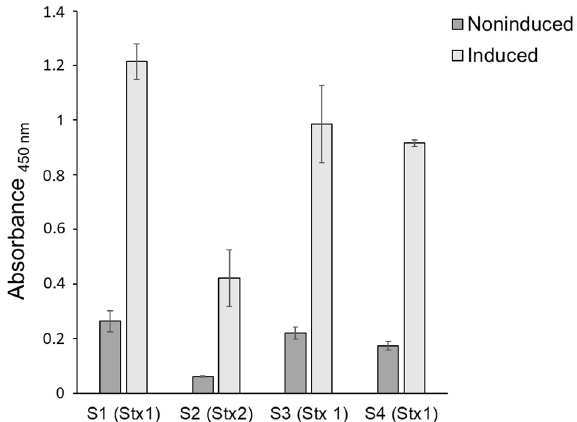
Figure 2. Semi-quantitative determination of Stx production of STEC isolates S1, S2, S3, and S4 after three hours induction with Mitomycin C (0.5 µg/mL). Error bars represent standard deviation.